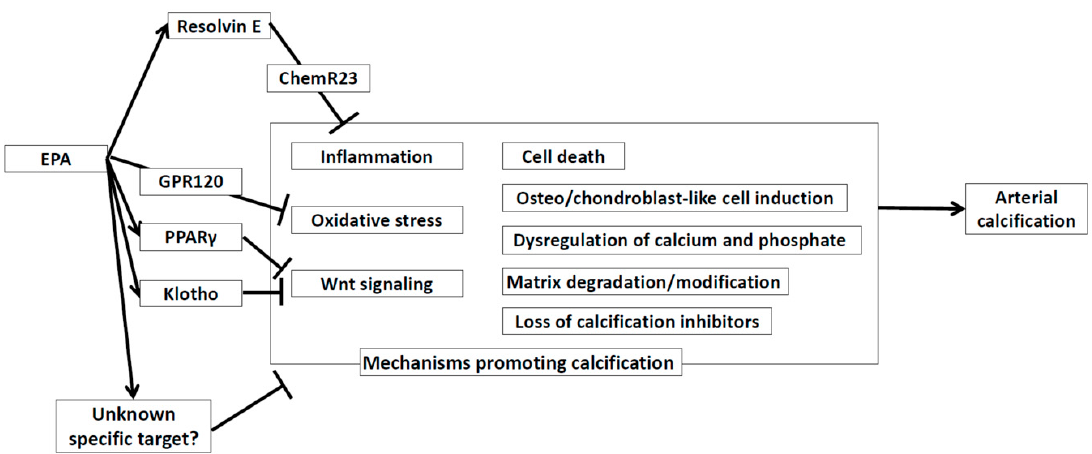
Figure 1. Proposed mechanisms on how EPA affects arterial calcification. EPA: Eicosapentaenoic Acid. ChemR23: Chemerin receptor 23. EPA: eicosapentaenoic acid. GPR120: G-protein coupled receptor 120. PPAR γ : Peroxisome Proliferator-Activated Receptor γ .